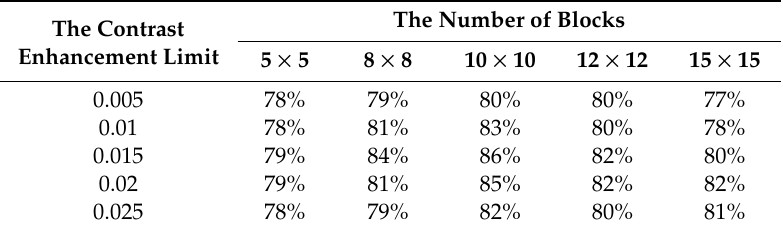
Table 1. The average relative overlap rate S of 25 sets of parameters used in contrast limited adaptive histogram equalization (CLAHE).